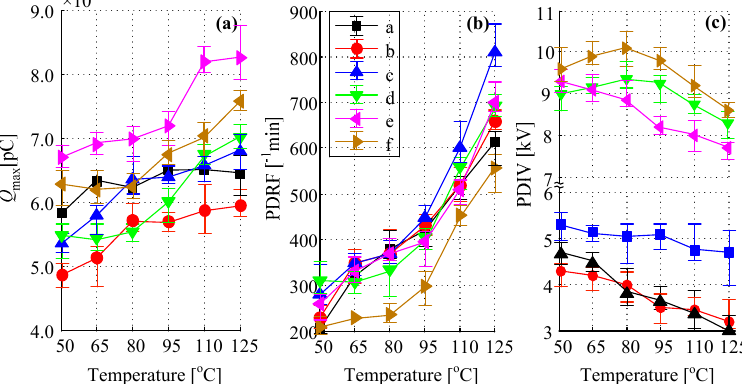
Figure 10. Measured parameters of six PD models under variable oil temperature. ( a ) The maximum PD quantity; ( b ) the PD repetitive rate; and ( c ) the PD inception voltage.